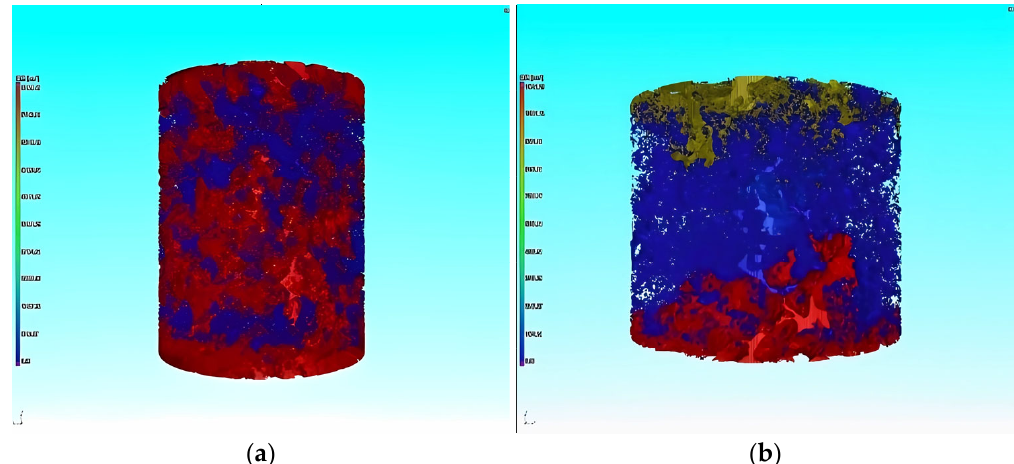
Figure 12. Three-dimensional void images of mixture under different molding methods. ( a ) Vibratory compaction. ( b ) Marshall compaction molding.